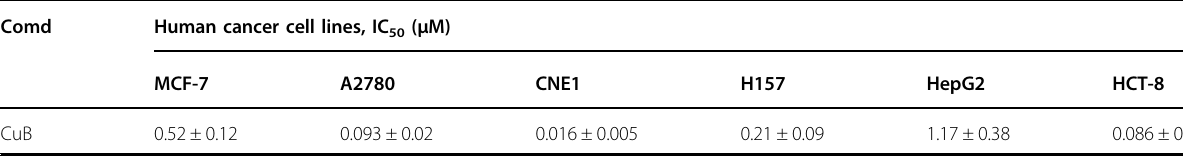
Table 1 Cytotoxicity of CuB towards different cancer cell lines in vitro.